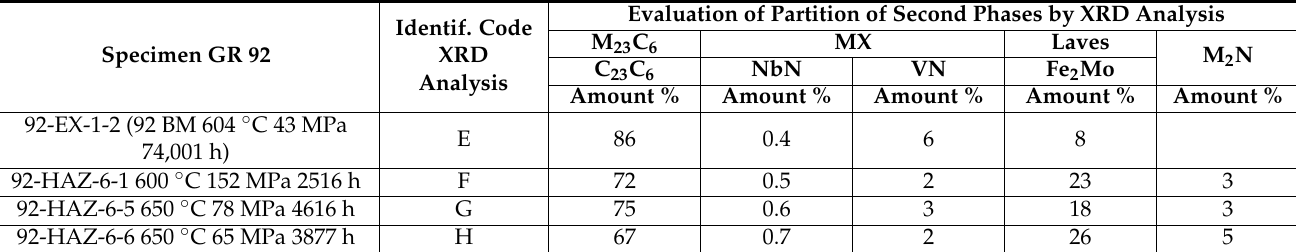
* suggested indication: to repeat XRD analysis. Table 12. Evaluation of precipitated phases in steel Grade 92 samples by XRD.